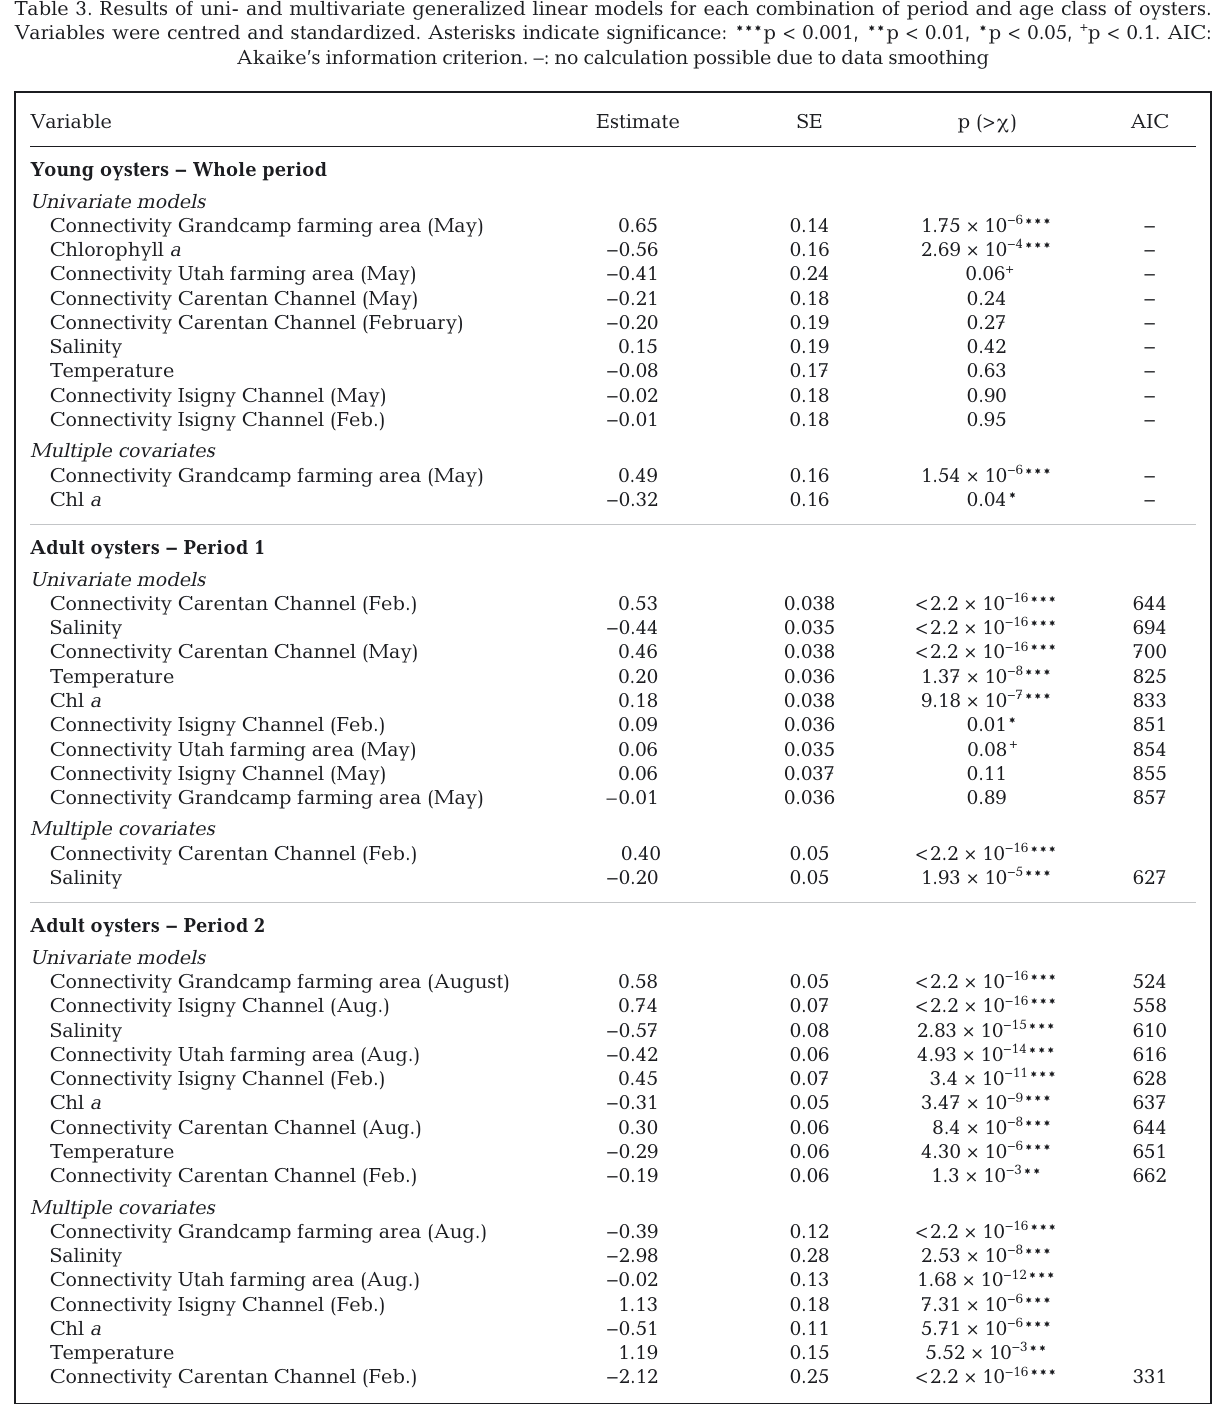
Maps of connectivity and chl a concentration allowed visualization of their spatial links with mortality (Figs. S4 & S11 in Supplements 2 and 6, respectively). Predicted maps of adult mortalities were also pro- duced by co-kriging using connectivity to a channel